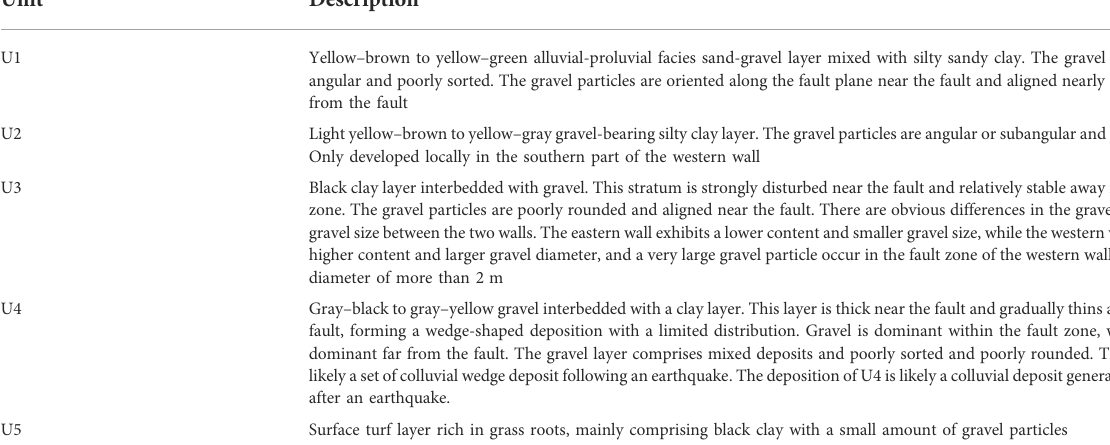
TABLE 3 Unit description of trench